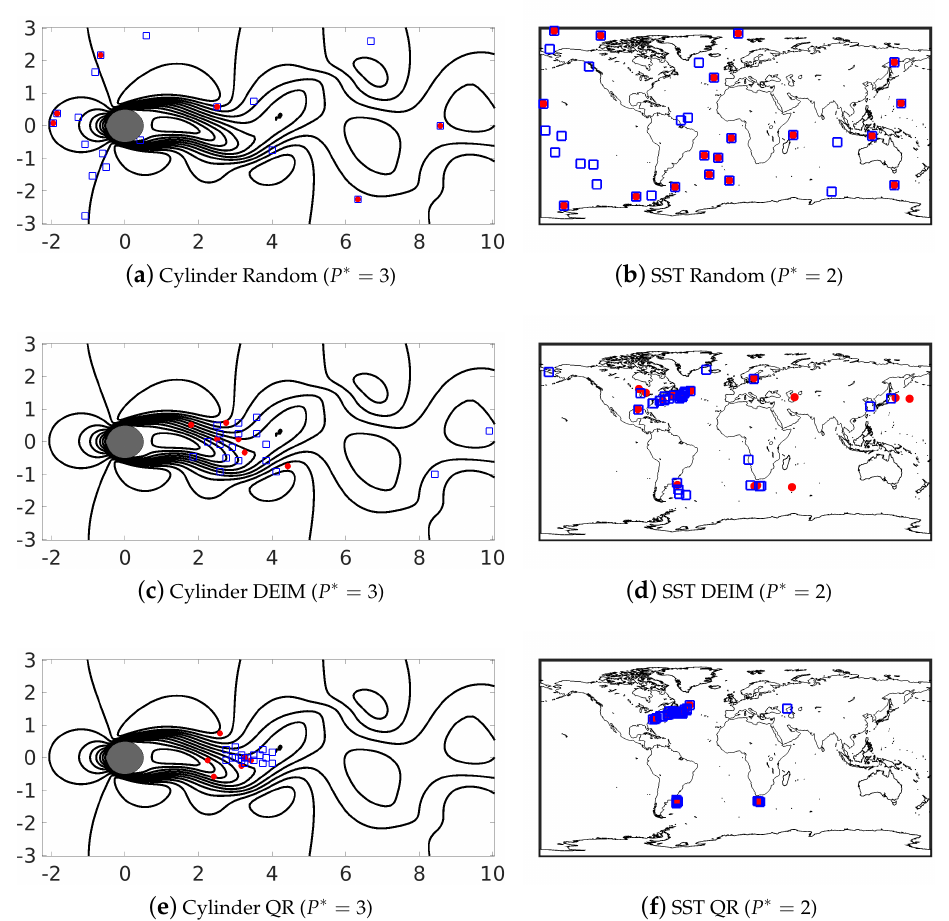
Figure 12. Sensor locations chosen using random ( top row ), discrete empirical interpolation method (DEIM) ( middle row ) and QR-pivoting ( bottom row ) sensor placement methods for budgets of P ∗ = 3 for cylinder flow (left) and P ∗ = 2 for SST data (right). Red dots: POD-basis-based sensor location; blue square: ELM-GS-basis-based sensor